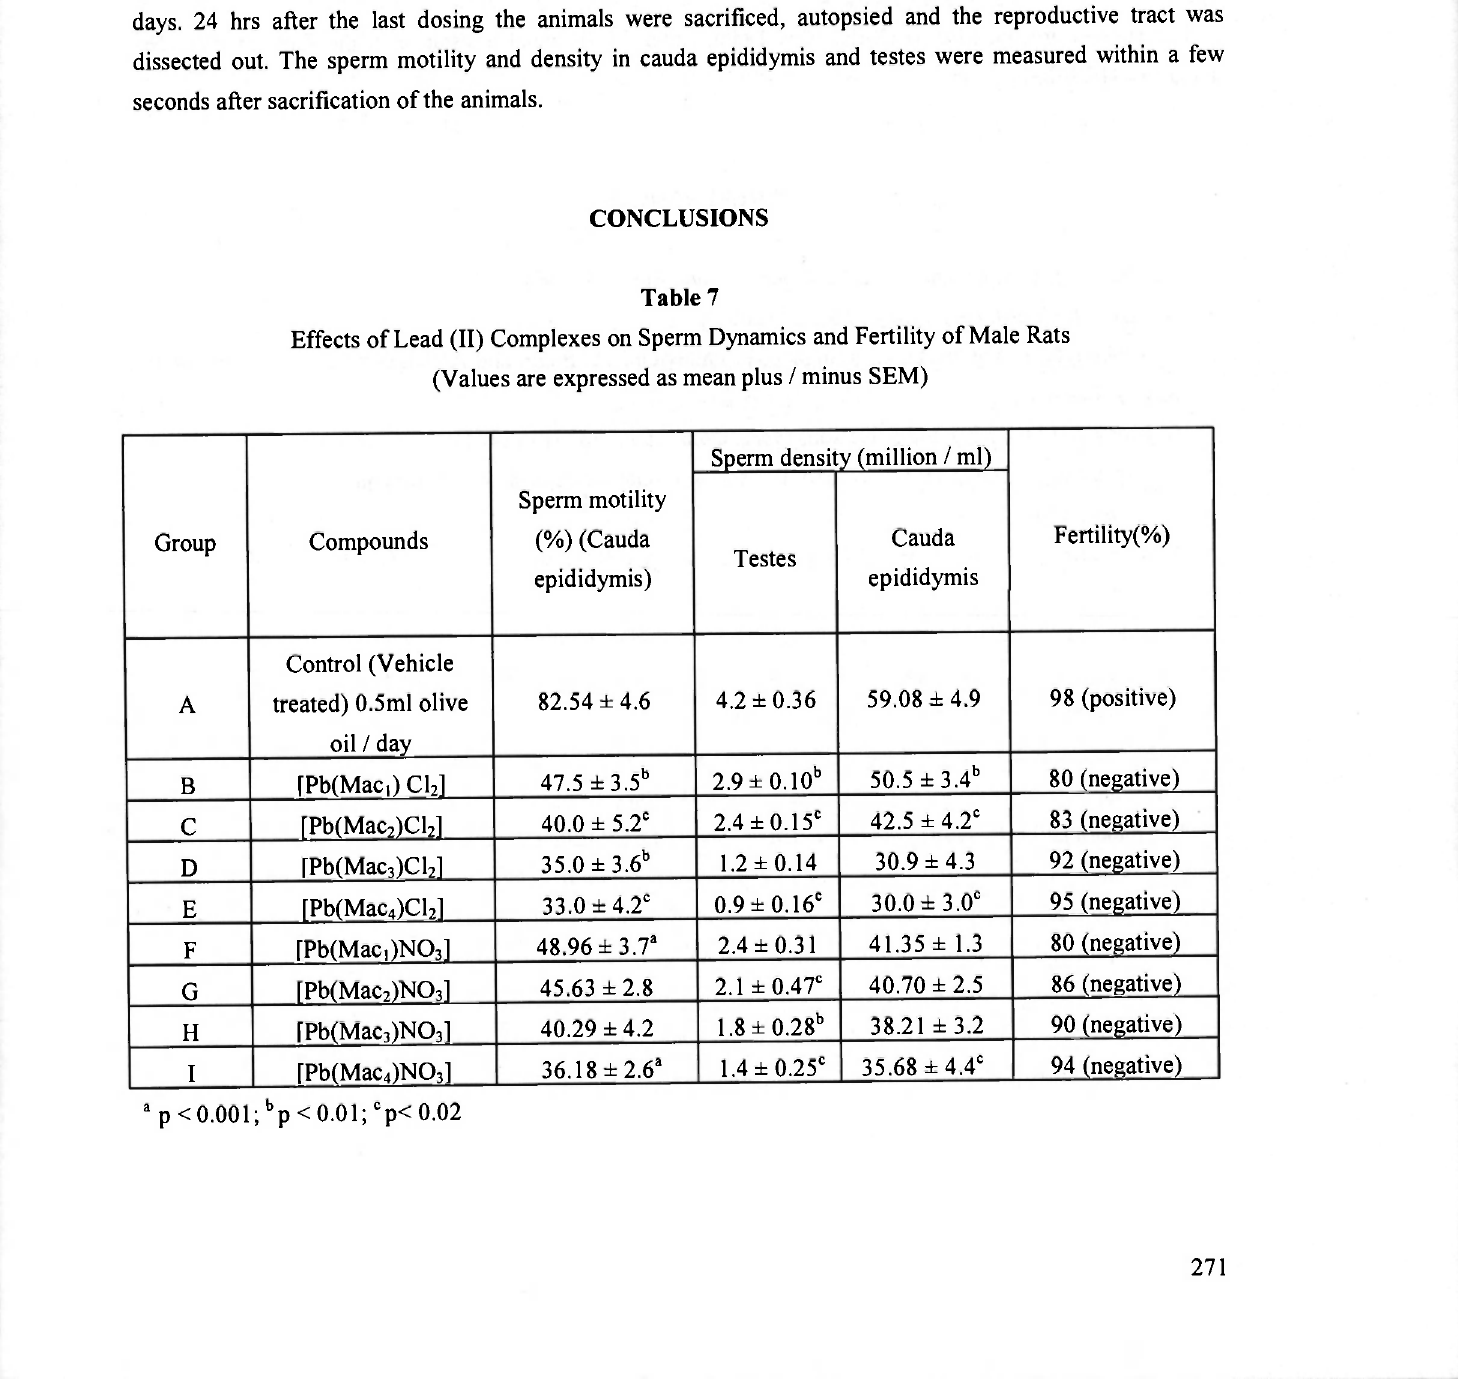
Effects of Lead (II) Complexes on Sperm Dynamics and Fertility of Male